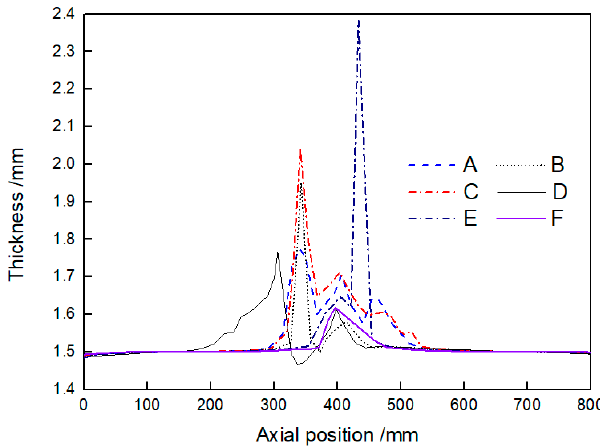
Figure 8. Thickness variation along the axial direction of hot formed workpiece.